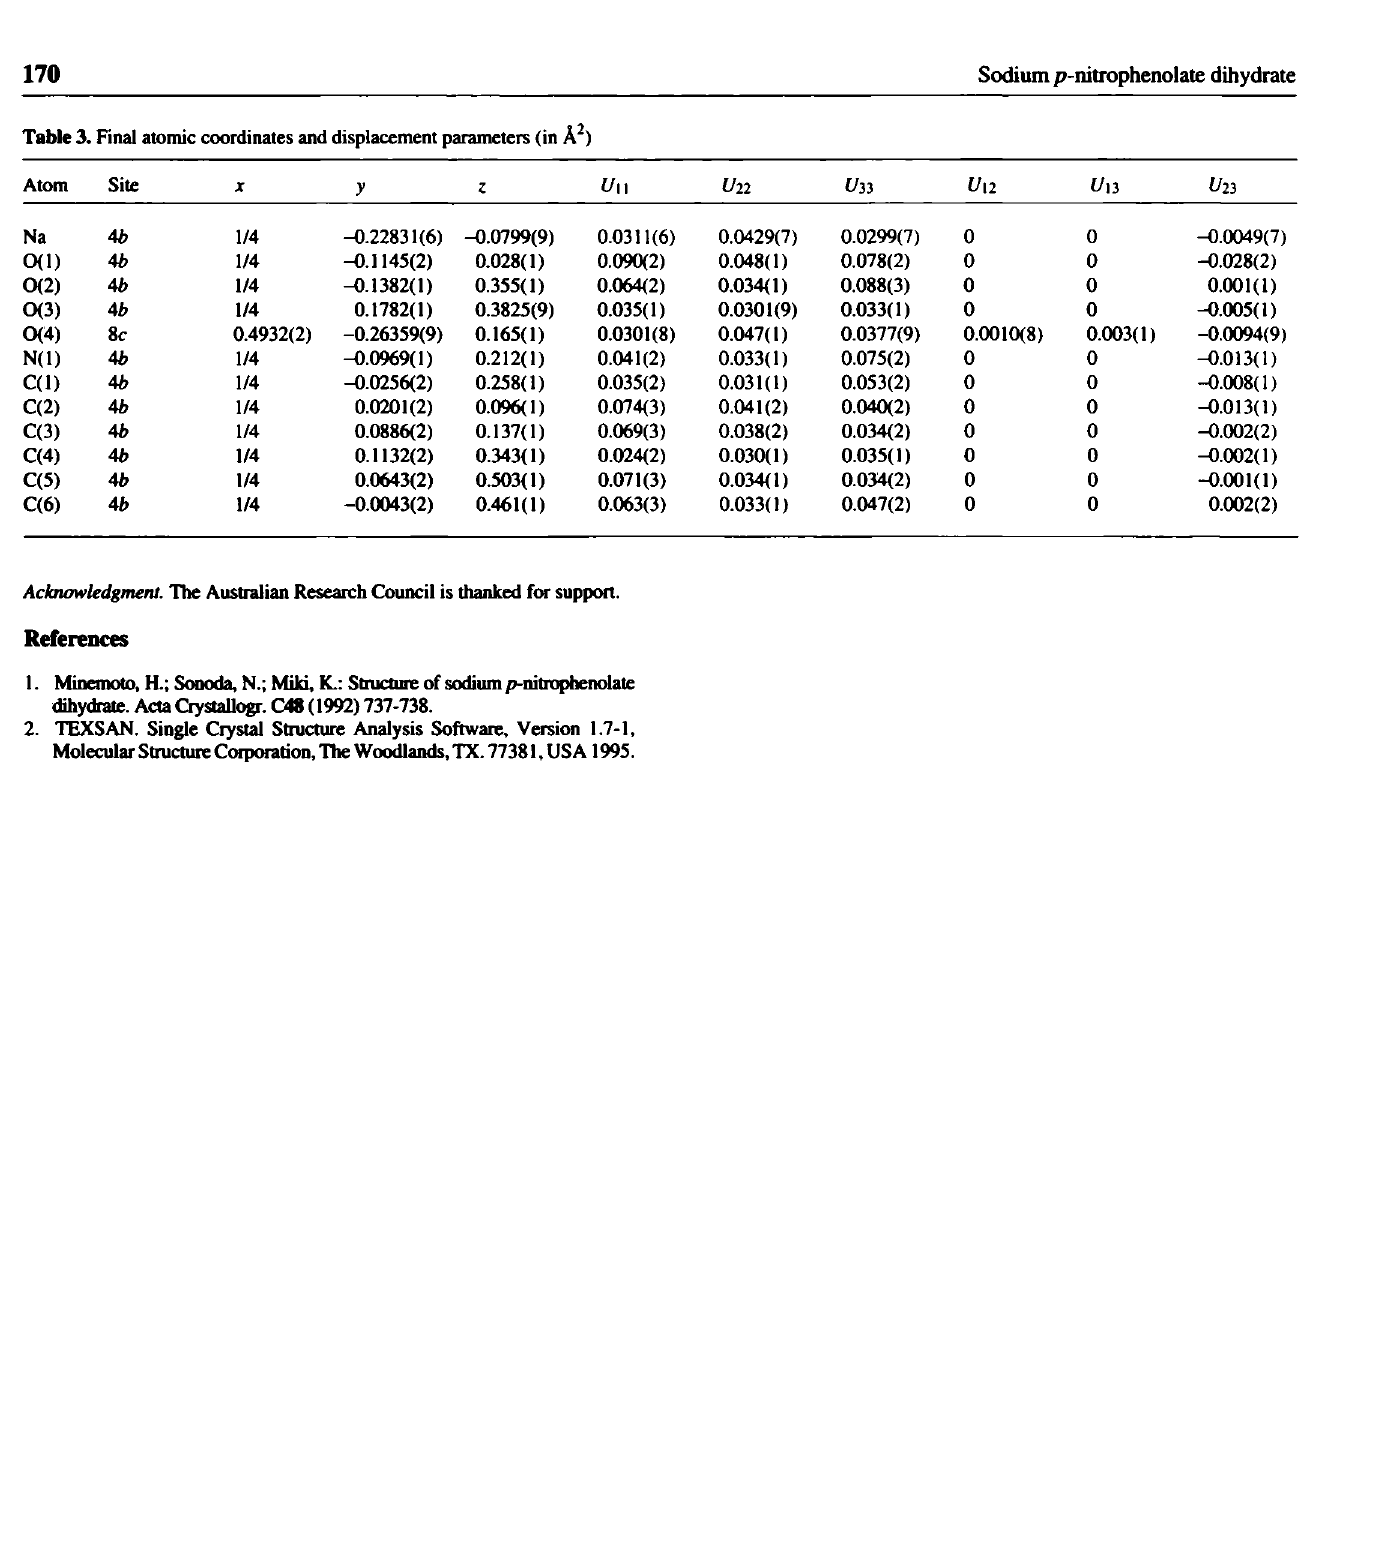
Table 3. Final atomic coordinates and displacement parameters (in Â 2